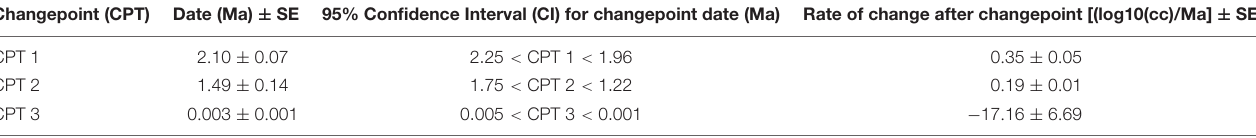
TABLE 1 | Estimates of changepoint dates—excluding small-brained Pleistocene Homo ( N = 981).